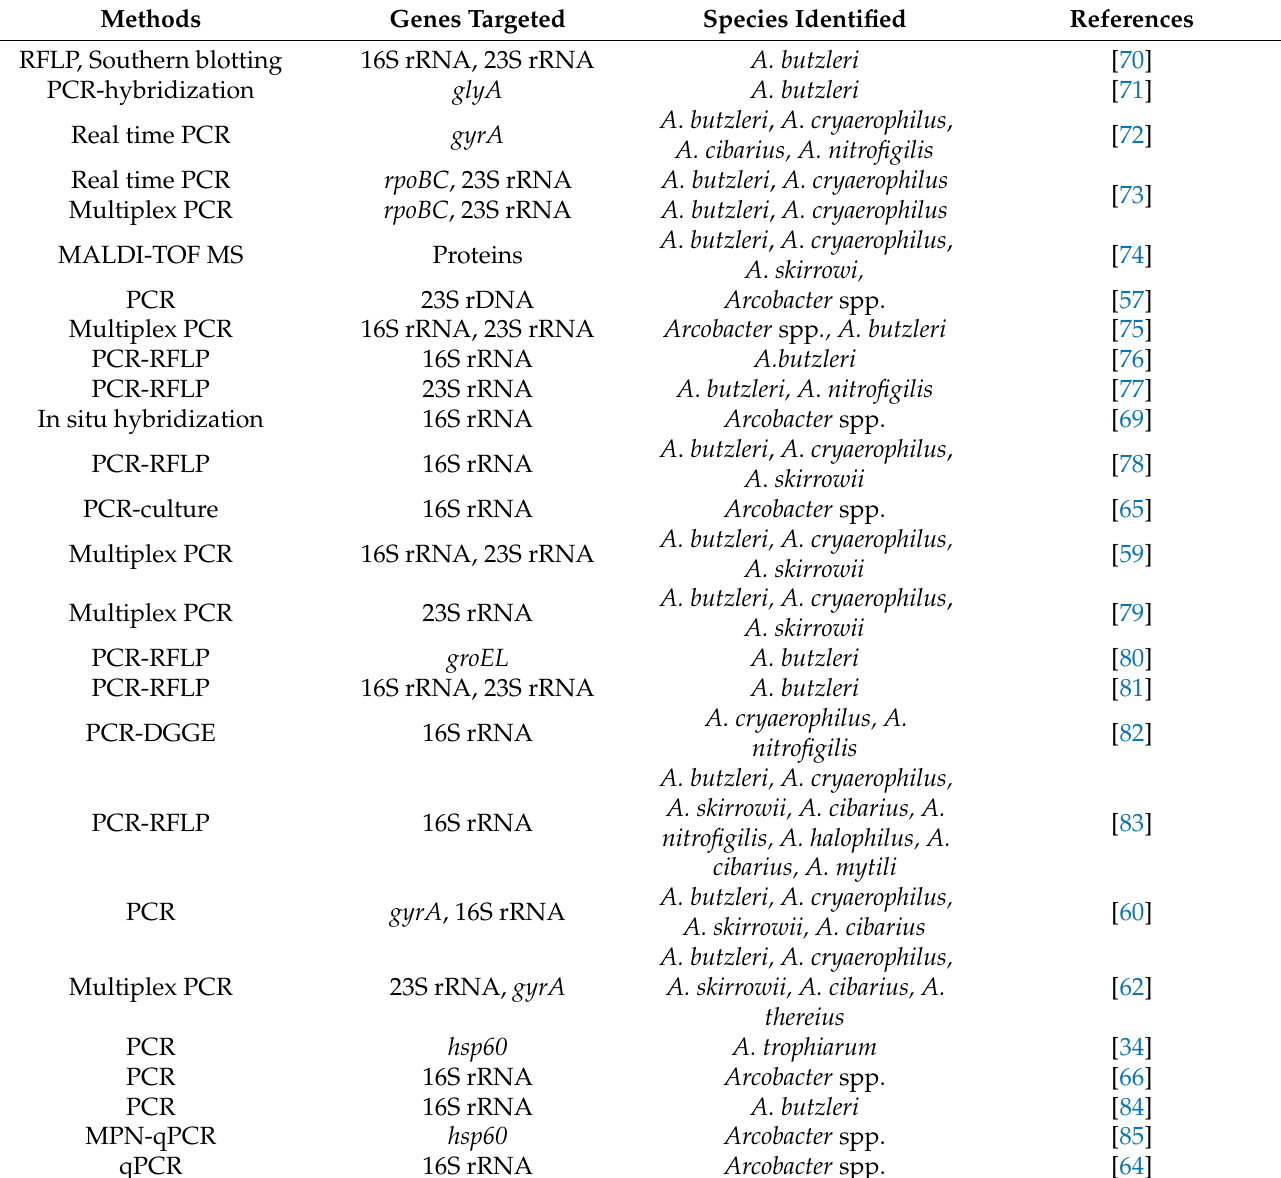
Table 4. Specific detection of Arcobacter using molecular-based